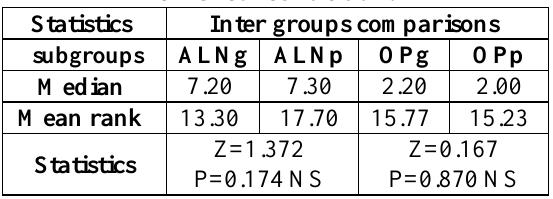
Table 2: Multiple comparison among groups for salivary OPG concentration.